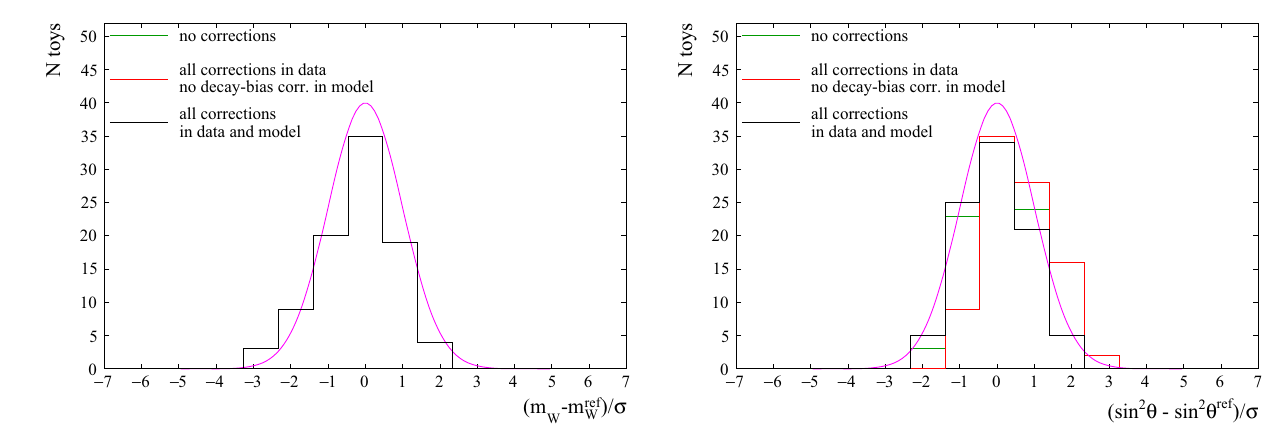
Table 2 The mean values of the distributions shown in red in Fig. 10 (where a 5 μ m mis-alignment along x is applied to the toy data), before and after applying the pseudomass corrections. The biases on m W are reported in MeV Bias in m W + (MeV) Bias in m W − (MeV) Bias in sin 2 θ eff Before(after)